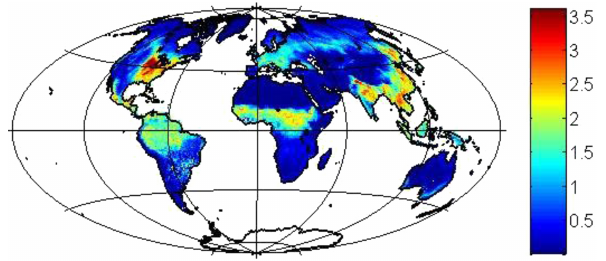
Figure 4. Monthly averaged binned map of GOME-2 SIF data for 1–31 August 2009 (mWm − 2 sr − 1 nm − 1 ).